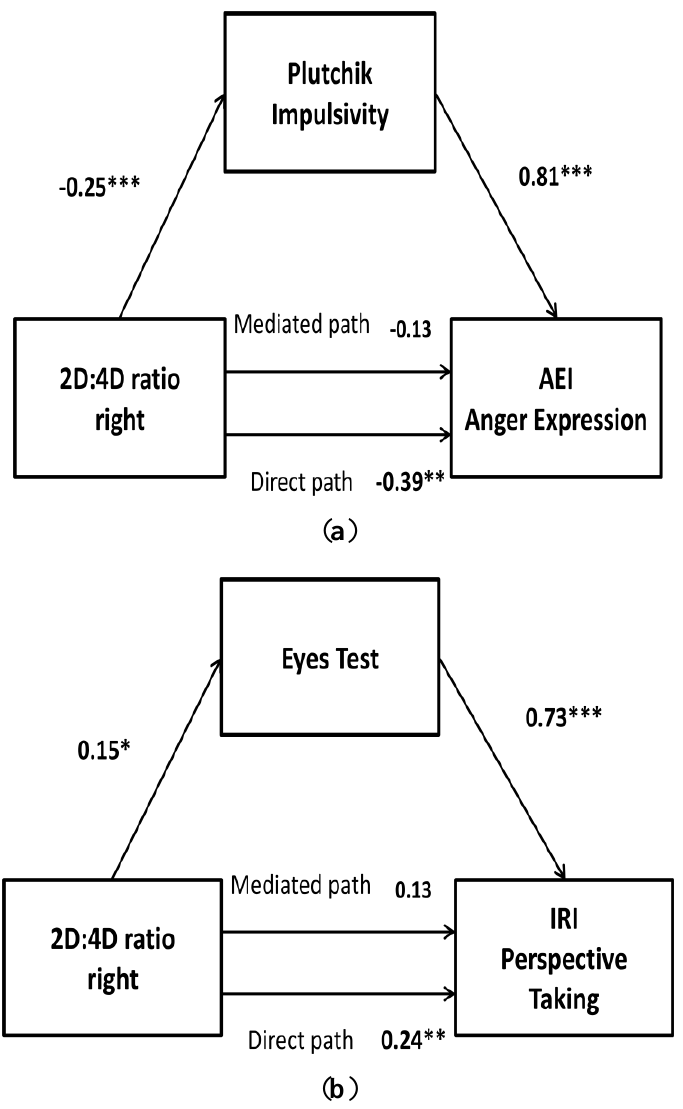
Figure 2. 2D:4D ratio right as a predictor of ( a ) anger expression (AEI) mediated by impulsivity and ( b ) IRI perspective taking mediated by eyes test in IPV